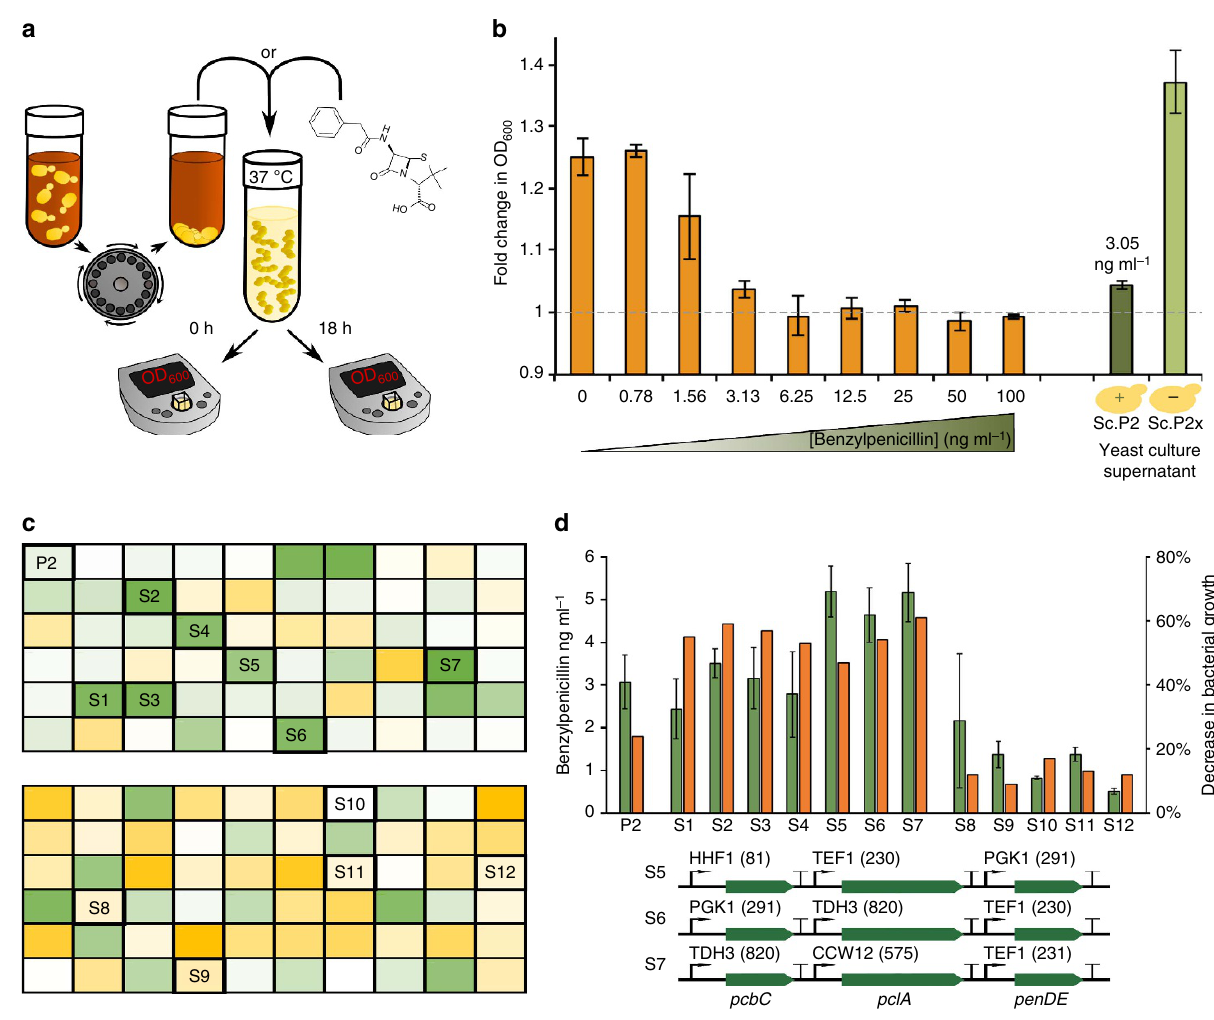
Figure 3 | Secreted benzylpenicillin is a bioactive antibiotic. ( a ) Schematic of the spent culture media antibiotic activity test. ( b ) Fold change in OD600 of S. pyogenes cell cultures grown either in the presence of increasing concentrations of benzylpenicillin standard over 18h (orange bars, left) or in the presence of supernatant from benzylpenicillin producing yeast Sc.P2 (dark green bar, plus sign) and yeast Sc.P2x with an inactive pcbAB gene (light green bar, minus sign). Concentration of benzylpenicillin in Sc.P2 supernatant as measured by LCMS is given above the dark green bar. Error bars show s.e.m. for three biological replicates. ( c ) Two 96-well plates of S. pyogenes were grown in the presence of supernatant from S. cerevisiae strains from the second promoter screen and the top strain from the first promoter screen (Sc.P2, abbreviated to P2). OD600 readings were taken at time zero and again after 18h of incubation at 37 (cid:2) C. Heatmaps indicate the degree of S. pyogenes overnight growth with green showing low OD600 (inhibtion of growth) and orange showing high OD600. ( d ) The percentage of inhibition of S. pyogenes growth from the screen (orange) and the LCMS-determined benzylpenicillin yields (green) are shown for spent growth media from Sc.P2 and 12 selected strains (seven showing high growth inhibition, five showing low growth inhibition). Error bars represent s.e.m. from three biological replicates. The promoters and their relative strengths (a.u.) used to express the three pathway genes in the three strains showing the highest benzylpenicillin production are shown underneath the